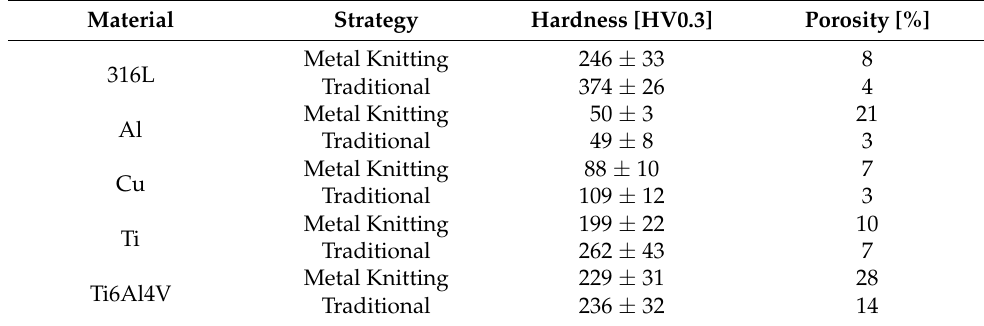
Table 4. CSAM material properties produced by traditional and Metal Knitting strategies.